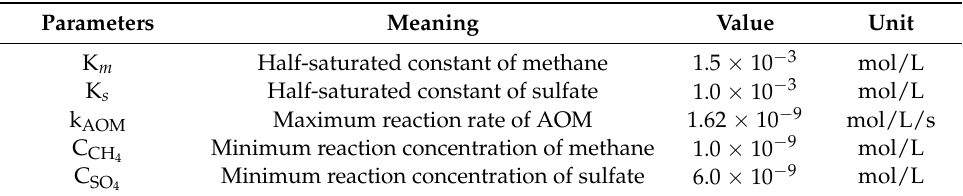
Table 1. Biogeochemical parameters. AOM: anaerobic oxidation of methane.